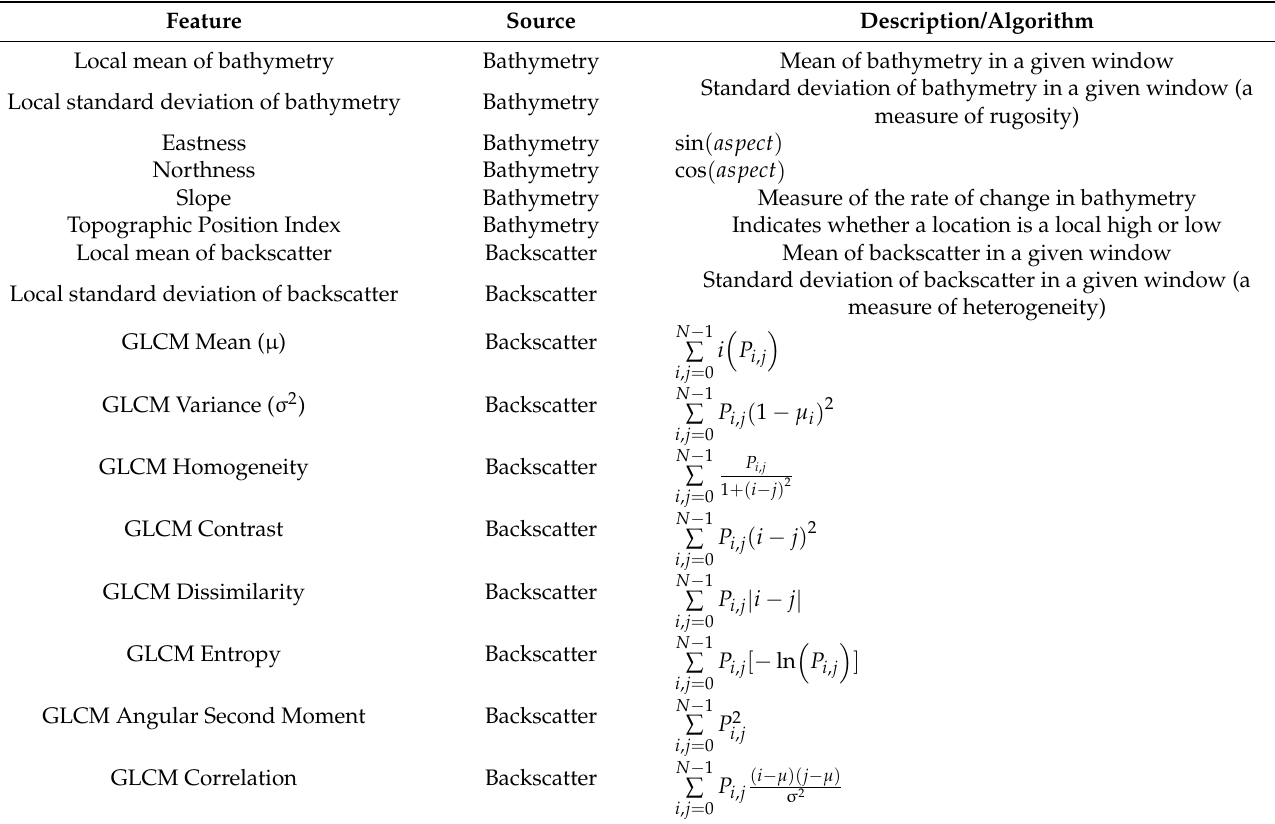
Table 1. Derivative features from the 10 m × 10 m bathymetry and backscatter surfaces for the Elbow of the west Florida shelf. Features were calculated using eight different scales of analysis from a 3 × 3 pixel to a 69 × 69 pixel moving window, and the resulting surfaces all have 10 m × 10 m resolution. Formulas for texture metrics are from Hall-Beyer [24]. N = number of rows or columns in the gray level co-occurrence matrix (GLCM) (equal to the number of gray levels, 32); i = row indices of the GLCM (equal to gray level of reference pixel); j = column indices of the GLCM (equal to gray level of neighboring pixel); P i,j = probability (relative frequency) of neighboring pixels having gray levels i and j. Feature Source